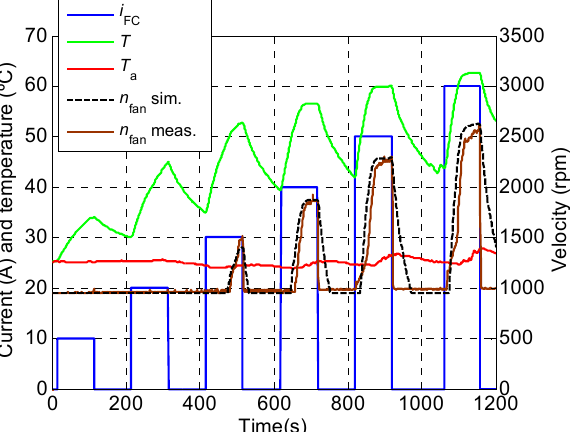
), FC operating temperature ( T FC